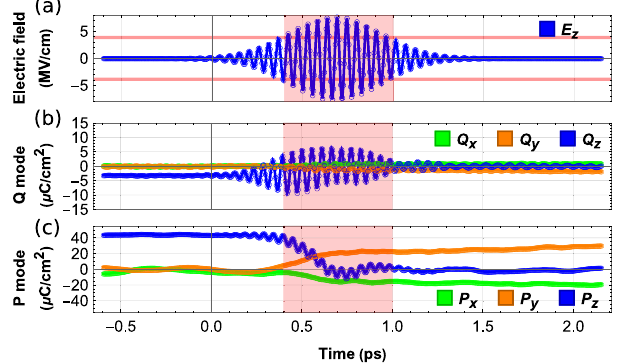
Fig. 2 Squeezing effect in T-phase. Temporal behavior of the Q ( b ) and P ( c ) modes at 400K, as a response to the electric fi eld ’ s pulse shown in a and when starting from a T-phase (note that the full-width-half-maximum of the pulse is marked by pink